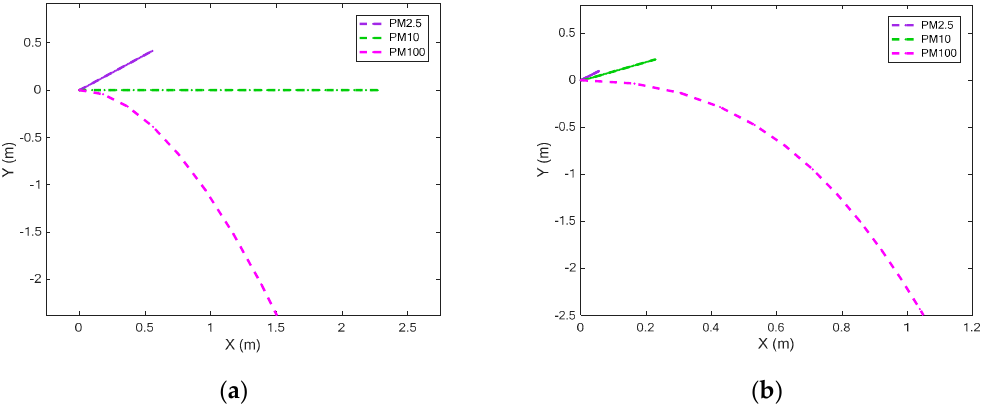
Figure 15. Under the same drag force and electric field, the separation effect of PM 2.5 , PM 10 , and PM 100 : ( a ) E2 = 433 V, mu = 10 − 7 ; ( b ) E2 = 866 V, mu = 10 − 6 .